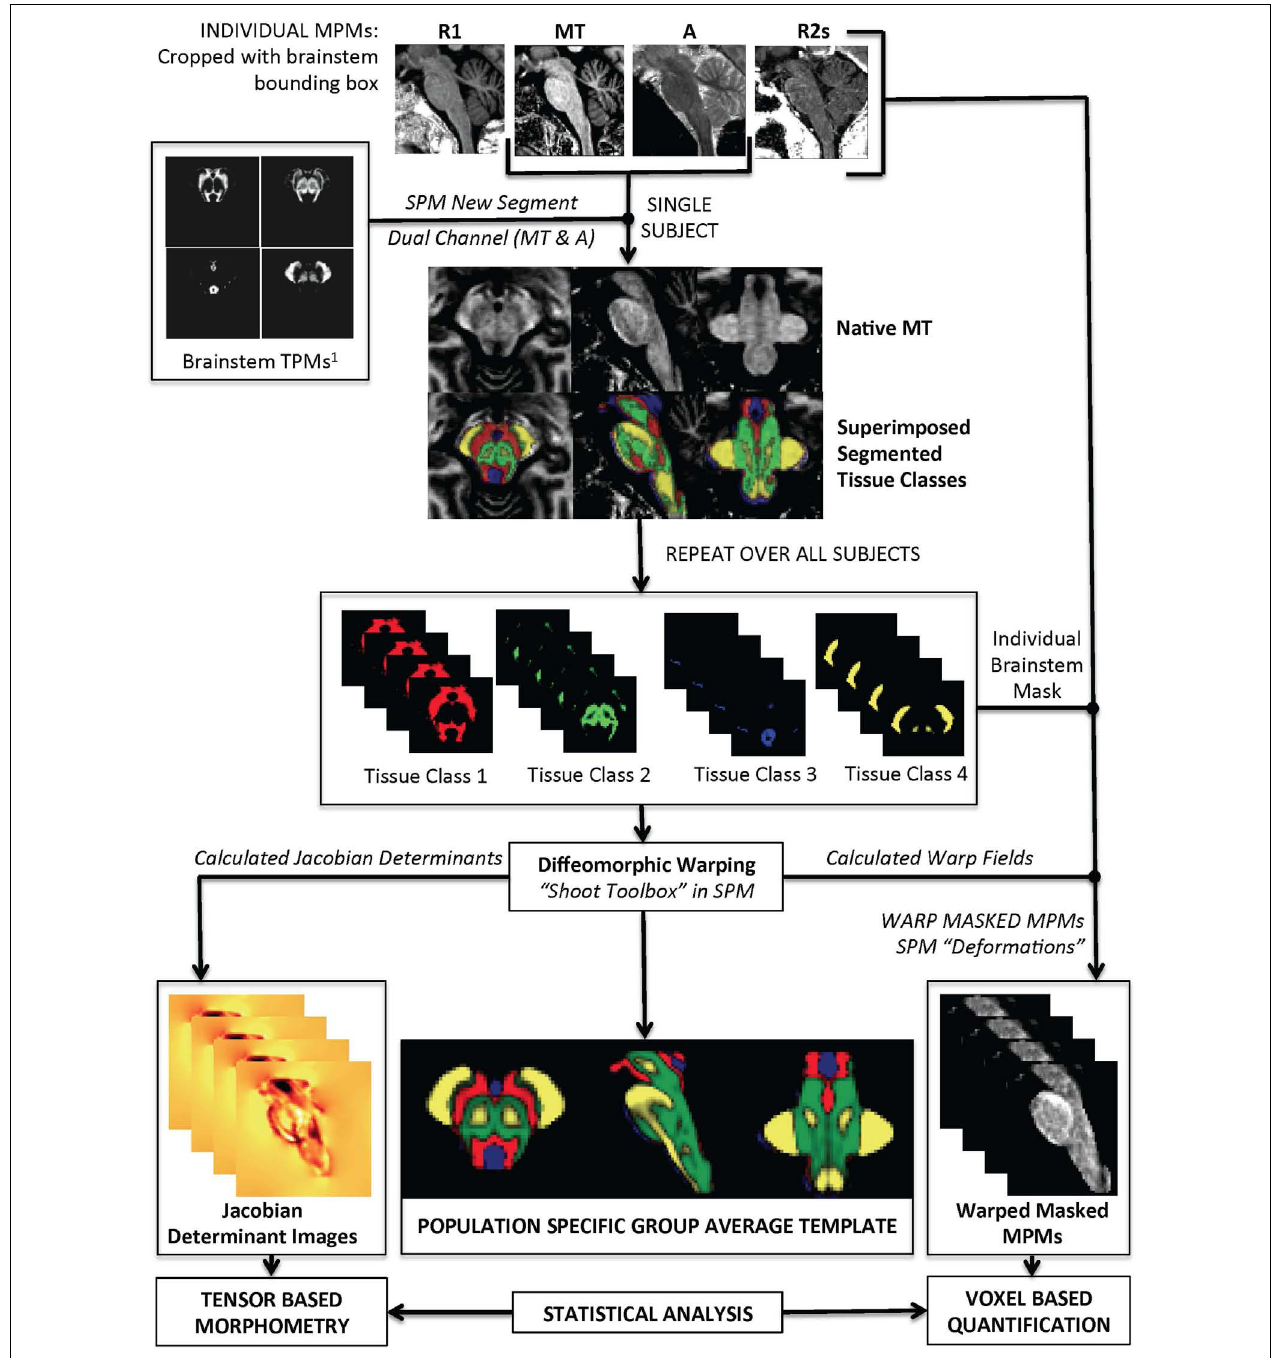
FIGURE 2 | Summary of segmentation pipeline .This includes examples of the Multiparameter Maps (MPMs) as shown at the top of the